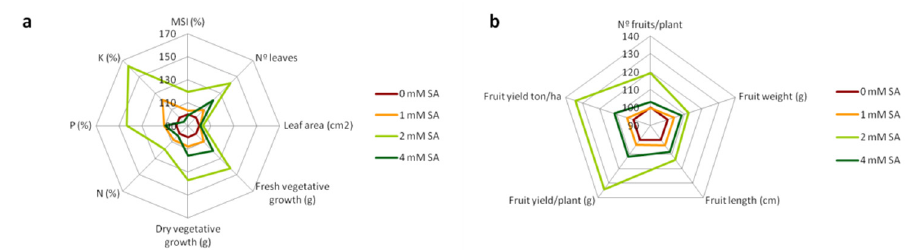
Figure 5. Effect of foliar SA applications on agronomic vegetative growth parameters ( a ) and fruit-yield-related attributes ( b ). Data are expressed as percentage of the corresponding control value in the absence of SA treatment. For means ± SE values and statistical analysis see Supple- mentary Table S3.